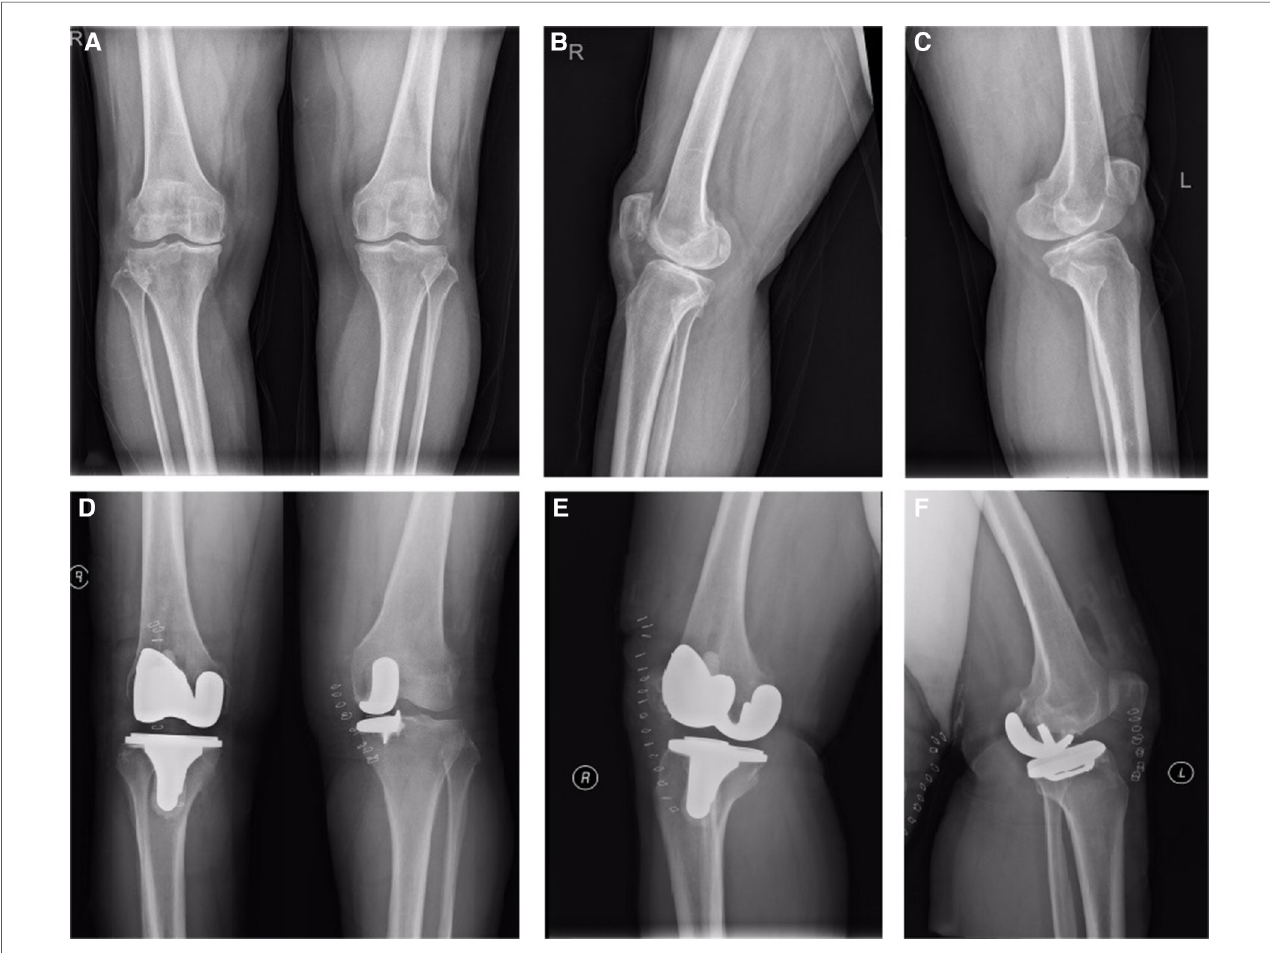
FIGURE 3 pre-operative (10 days) and post-operative (2 days) X-ray examinations of a 68-year-old women with bilateral osteoarthritis. ( A ) Anteroposterior position 10 days before operation. ( B ) Lateral position of right knee joint 10 days before operation. ( C ) Lateral position of left knee joint 10 days before operation. ( D ) Anteroposterior position 2 days after operation. ( E ) Lateral position of right knee joint 2 days after operation. ( F ) Lateral position of left knee joint 2 days after